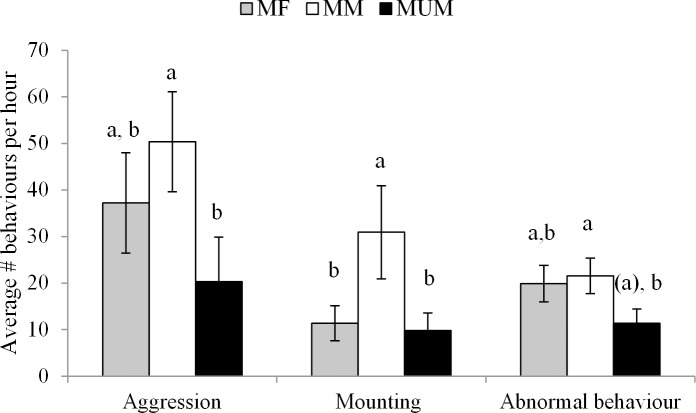
Average number of behaviours per hour at holding on farm and at lairage for each treatment (MF = mixed with females, MM = mixed with males, MUM = unmixed males).Different letters indicate significant differences (P < 0.05), letters within brackets tend to be different from the same letter without brackets (0.05 ≤ P ≤ 0.1).